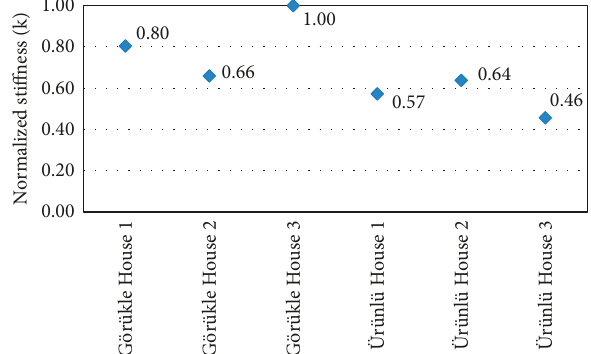
Figure 13: The normalized stiffness ratios of the masonry walls according to the fundamental frequencies in x